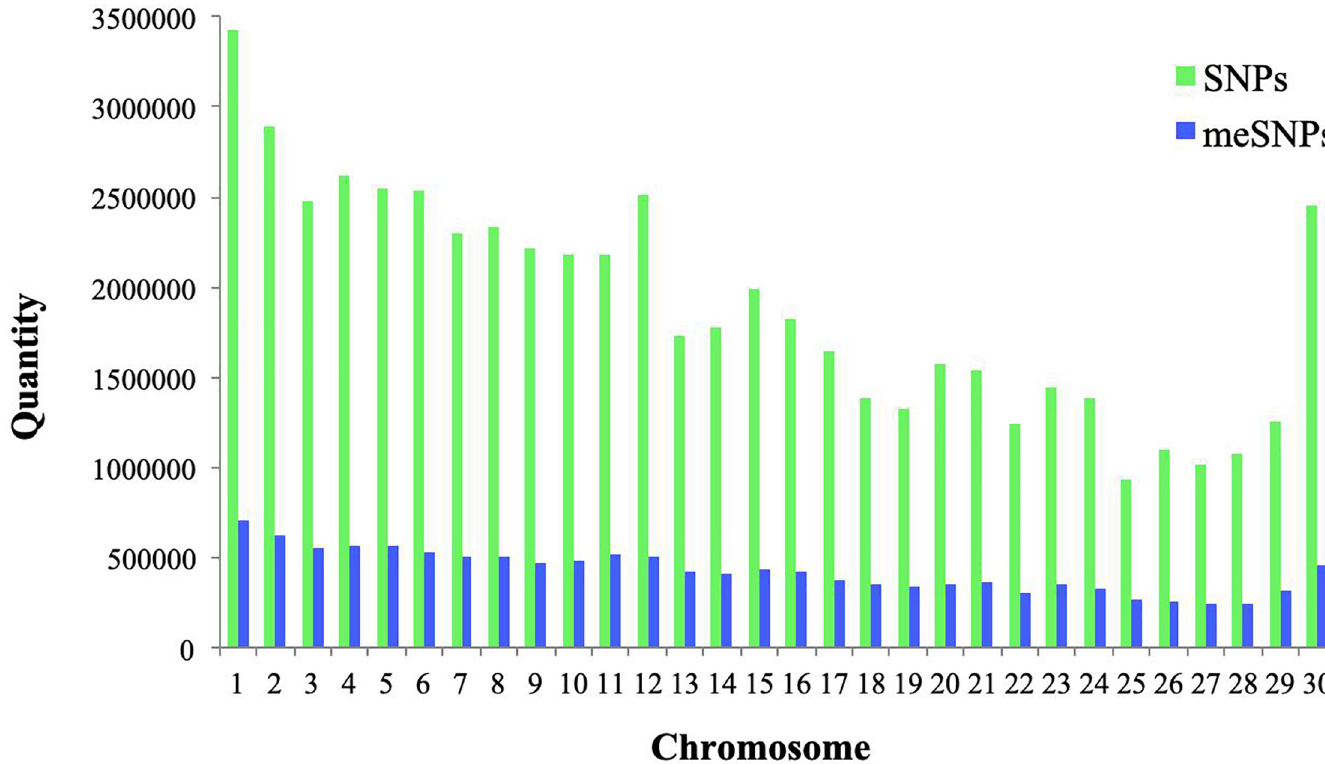
Fig 2. SNPs versus meSNPs. Number of meSNPs identified in comparison to the total number of SNPs annotated in Run5 of the 1000 Bull Genomes Project by chromosome.